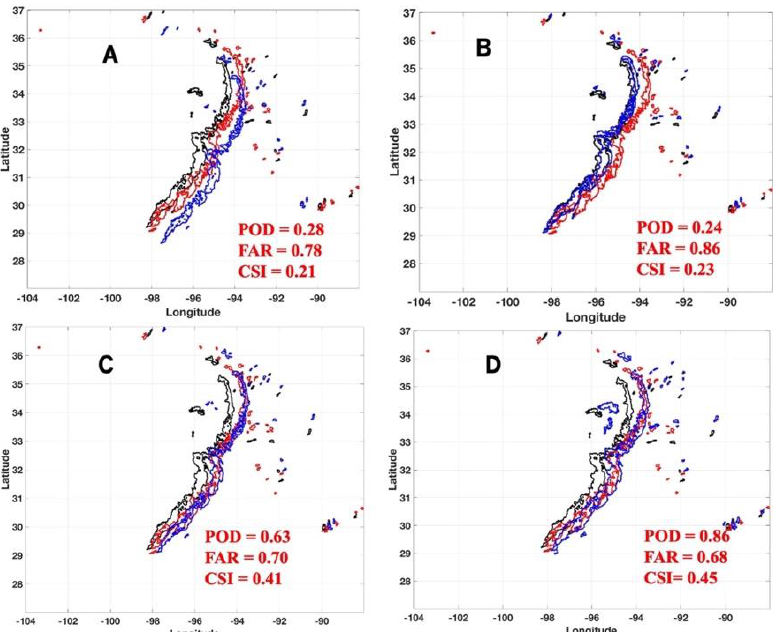
Figure 10. The results of ( A ) applying centroid-tracking only; ( B ) using the model field only; ( C ) from the combination of centroid-tracking and the model field without the adjustment of the precipitation properties; ( D ) similar to ( C ) but with the adjustment of the precipitation properties. The QPE at 2200 UTC, QPE at 2300 UTC, and prediction at 2300 UTC are indicated by black, red, and blue lines.